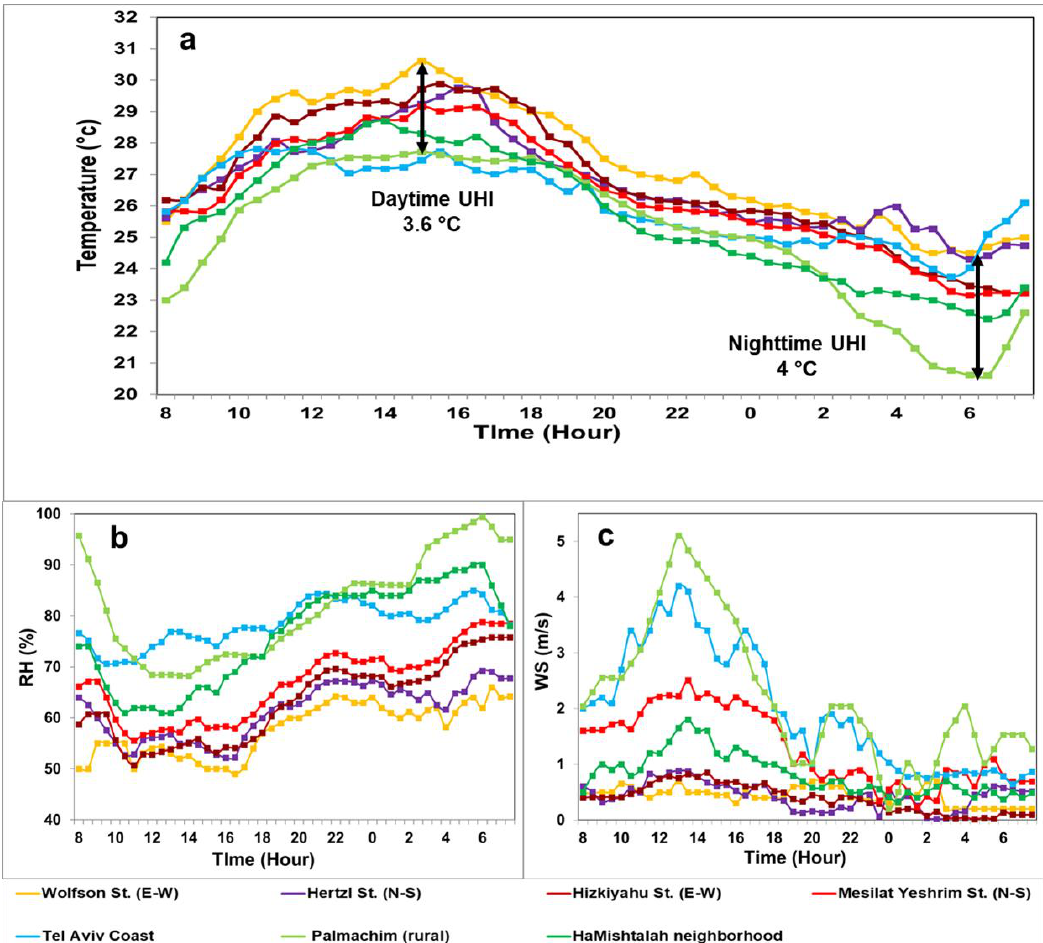
Figure 4. Meteorological monitoring in the selected streets of Shapira and Florentine neighborhoods during 20–21 of June, 2019: ( a ) Air temperature. ( b ) Relative humidity. ( c ) Wind speed. At midday, the relative humidity values at the rural station were higher by 20–25% than at the city center and during the night by 35%. The relative humidity values along the north-south street were higher by ~5% than along the east-west street (Figure